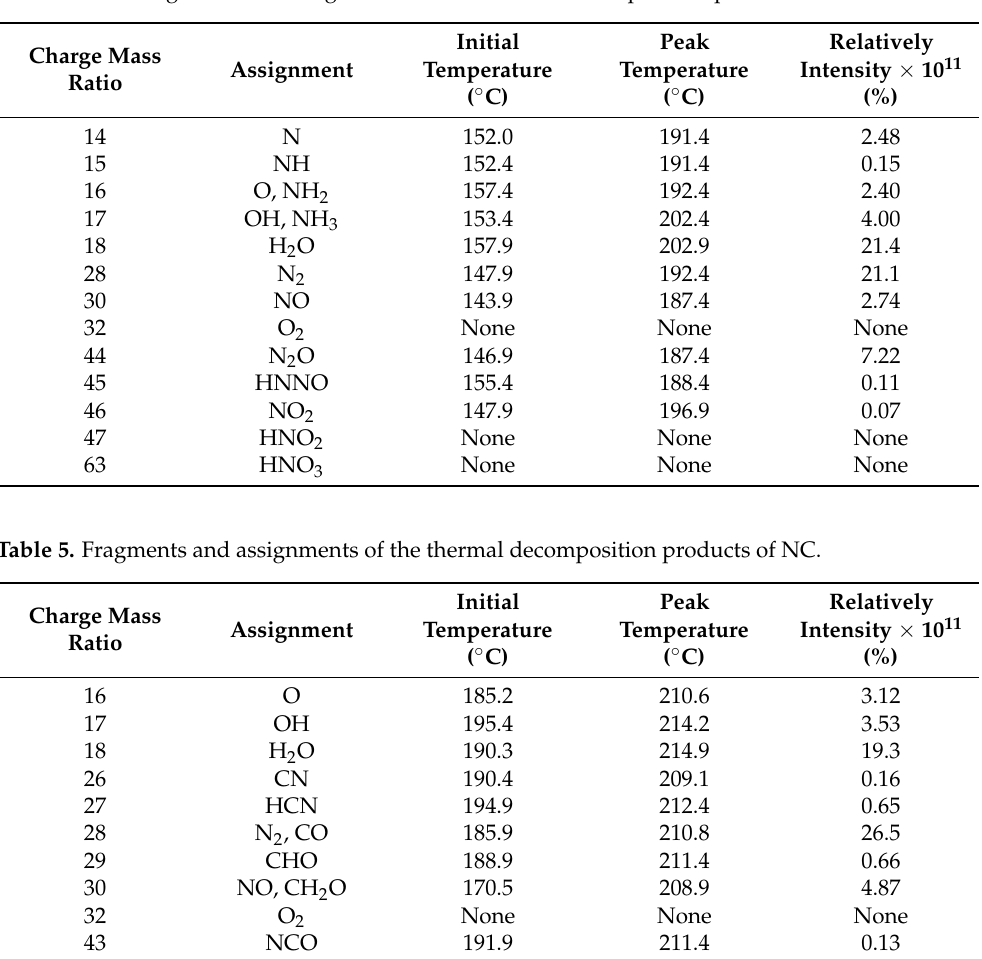
Table 4. Mass fragments and assignments of the thermal decomposition products of ADN.